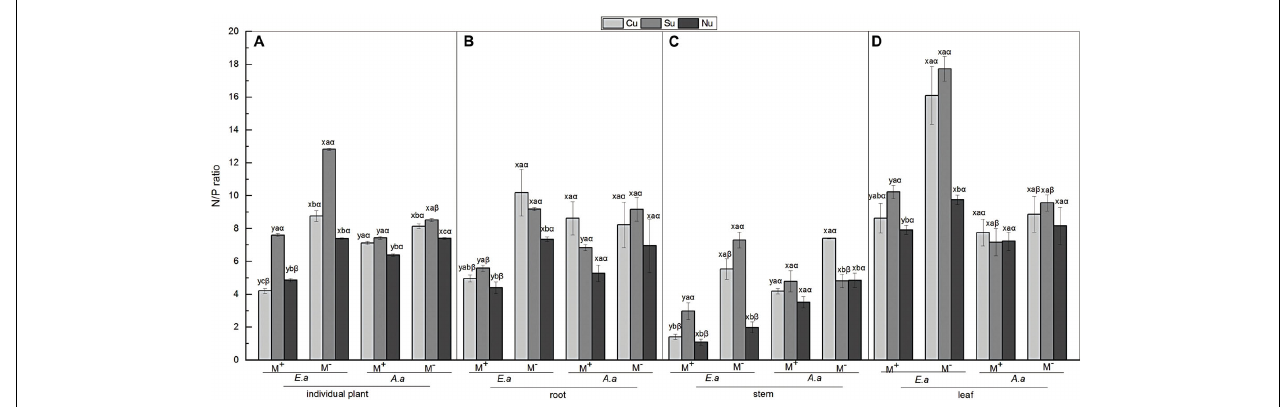
FIGURE 5 | N/P ratio of E. adenophorum and A. annua seedlings including in root, stem and leaf. Abbreviations: E. a and A. a ; M + and M − ; Cu and Su and Nu, meaning same as in Figure 2 . The lowercase letters x and y, (a, b, c). The Greek letters α and β above the bars, they mean the same as in Figure 2 .